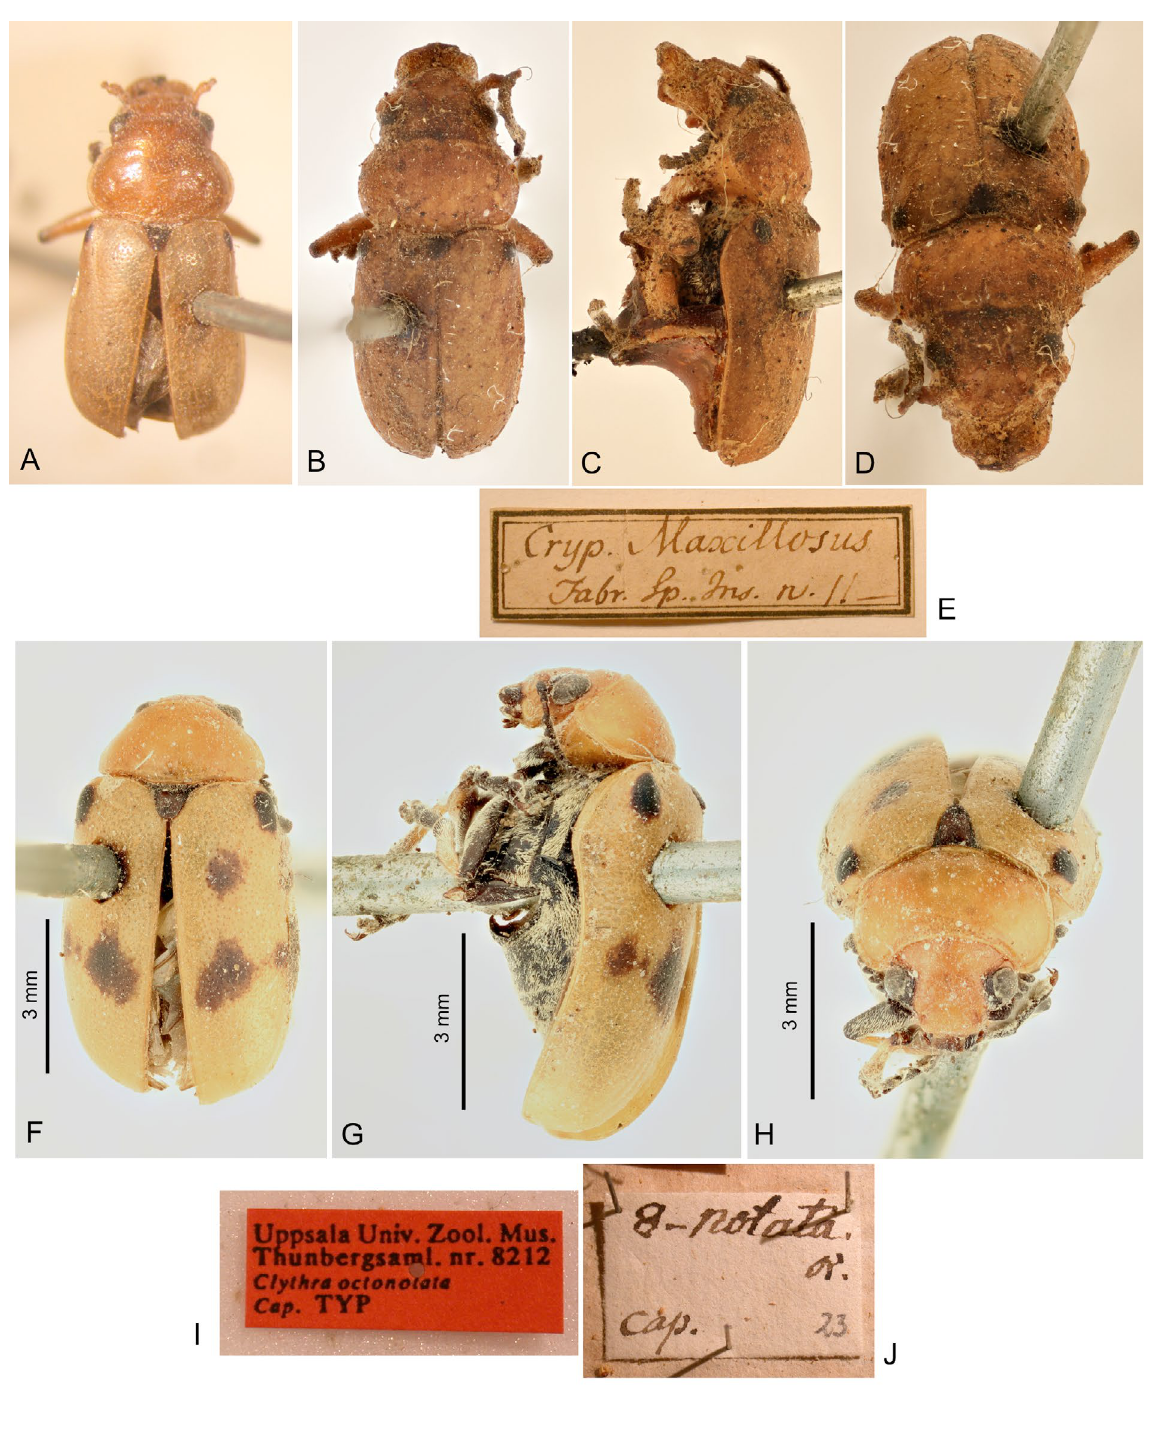
Fig. 1. Antipus rufus DeGeer, 1778. A . Syntype, ♂, not measured, NHRS. B–E . Syntype of Cryptocephalus maxillosus Fabricius, 1781, ♂, not measured, BMNH. B . Dorsal view. C . Lateral view. D . Frontal view. E . Label. F–J . Syntype of Clythra octonotata Thunberg, 1821, ♀, 7.5 mm, UUZM. F . Dorsal view. G . Lateral view. H . Frontal view. I . Label. J . Box